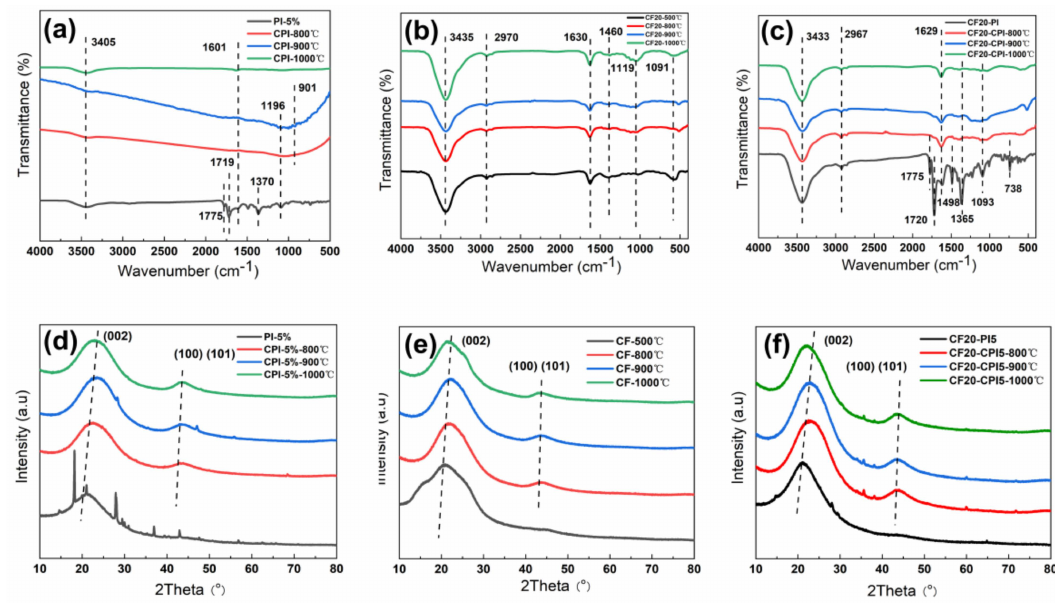
Figure 8. FTIR spectra of ( a ) aerogels, ( b ) foams and ( c ) composites; XRD patterns of ( d ) aerogels, ( e ) foams and ( f )